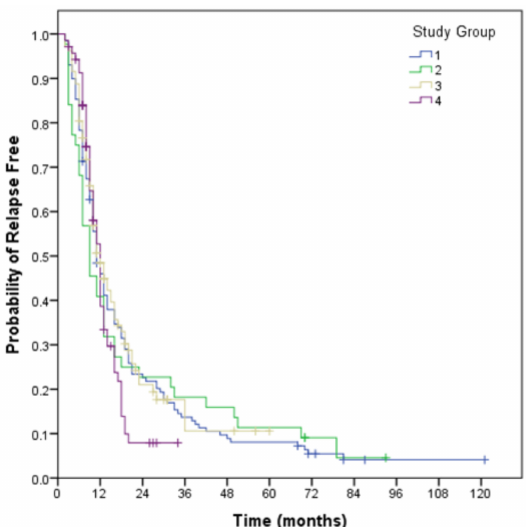
Figure 1. Relapse free survival for geographical Groups 1–4. (Group 1: Metropolitan centre pre-2013; Group 2: Regional residents managed pre-2013 at the metropolitan centre; Group 3: Metropolitan centre post-2013; Group 4: Regional residents managed post-2013 at the regional centre).